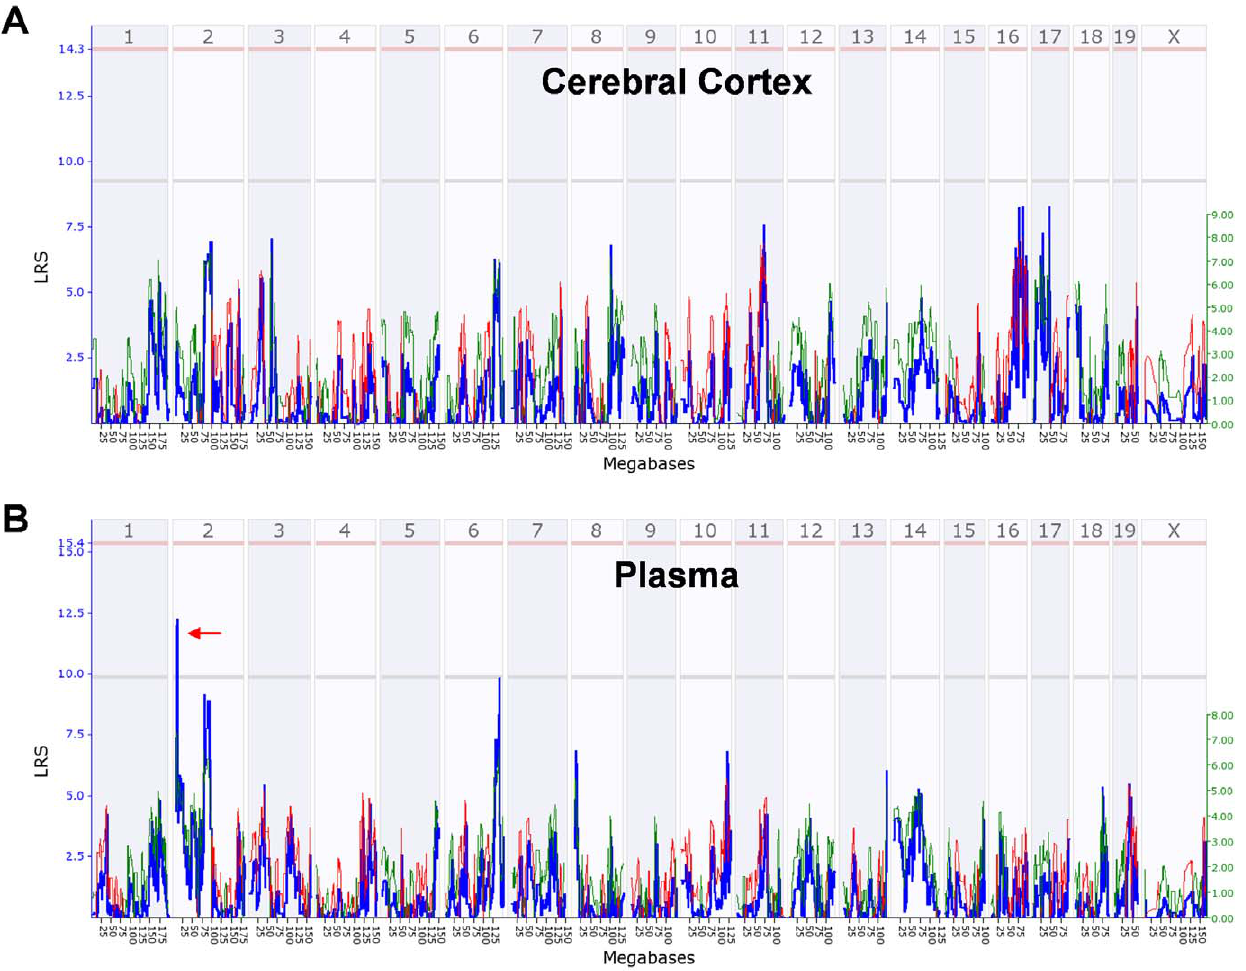
Figure 8. Genome-wide interval mapping for the dexamethasone-induced changes in (A) cerebral cortical and (B) plasma DOC levels across the BXD strains and their parental strains. Mice were injected with dexamethasone (0.075 mg/kg, sc) or saline at 8:00 am and were sacrificed 6 hours later. The % change of the average for dexamethasone-treated mice vs. the average for the respective saline-treated mice has been used for analysis. Panels show likelihood ratio statistic (LRS) scores across the entire genome. The y axis and the thick blue lines provide the LRS of the association between the trait and the genotypes of markers. The two horizontal lines are the suggestive (gray) and significance (red) thresholds computed using 1000 permutations. A suggestive QTL on chromosome 2 (red arrow) was identified. A positive additive coefficient (green line) indicates that D2 alleles increase trait values. A negative additive coefficient (red line) indicates that B6 alleles increase trait values.